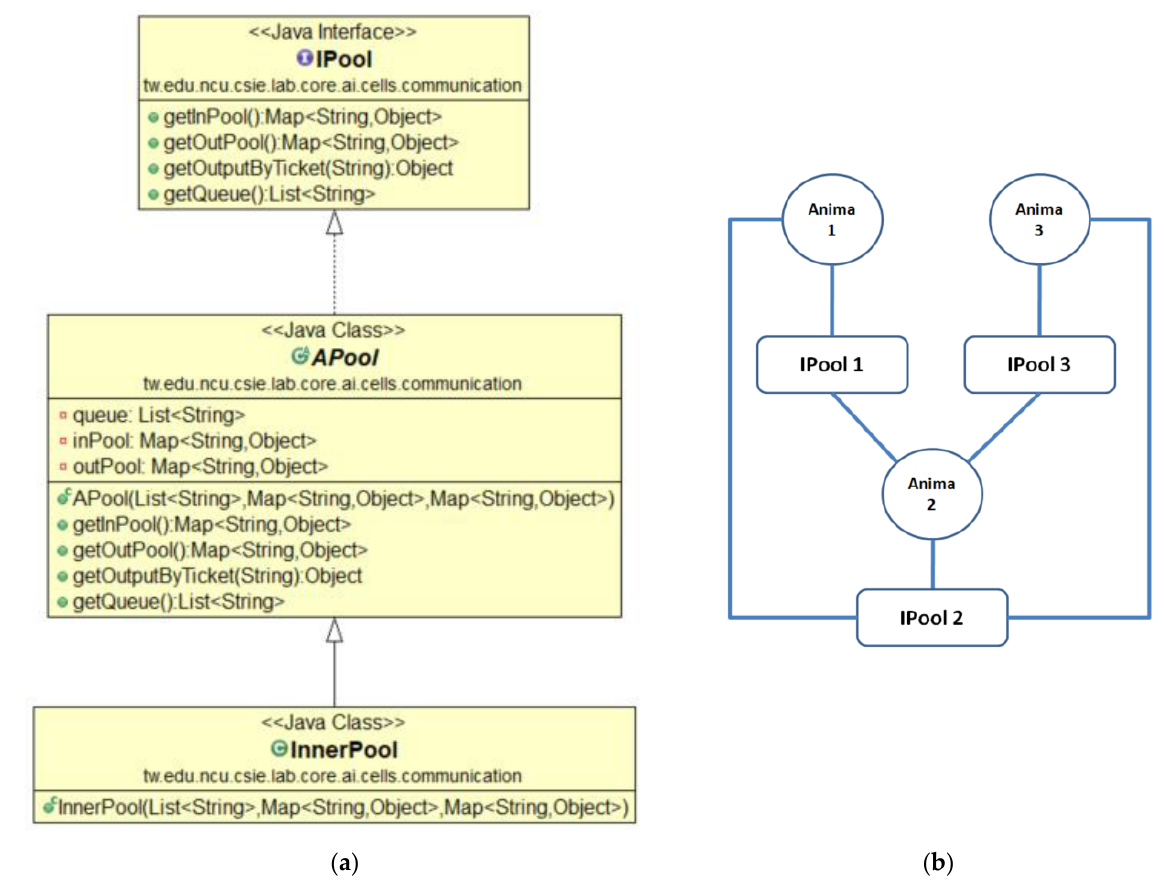
Figure 6. There are two graphs about the pool of anima containing ( a ) class diagram and ( b ) concept graph.